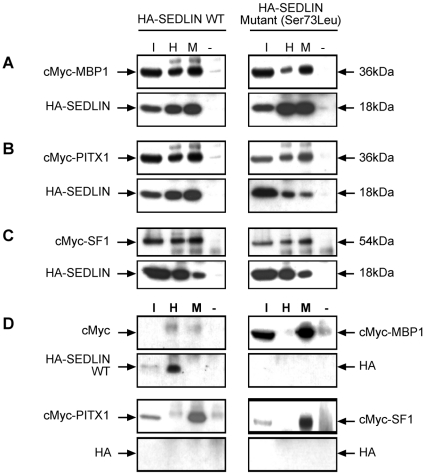
Interactions between SEDLIN, and MBP1, PITX1 and SF1.Co-immunoprecipitation studies using COS7 cells demonstrated interactions between wild-type SEDLIN, mutant SEDLINs (Asp47Tyr, Ser73Leu, Phe83Ser, Val130Asp and Gln131Stop, only data from Ser73Leu SEDLIN shown) and MBP1, PITX1 and SF1. (A) cMyc-MBP1 co-transfected with wild-type or mutant HA-SEDLIN; (B) cMyc-PITX1 co-transfected with wild-type or mutant HA-SEDLIN; (C) cMyc-SF1 co-transfected with wild-type or mutant HA-SEDLIN; and (D) empty cMyc vector co-transfected with HA-SEDLIN or empty HA vector co-transfected with cMyc-MBP1, cMyc-PITX1 or cMyc-SF1 constructs. Lysates were incubated with either anti-cMyc polyclonal antibody (M) or anti-HA polyclonal antibody (H), or without any antibody as a negative control (−) and immunoprecipitated with Protein G-Sepharose beads. Protein complexes were eluted and resolved on SDS-PAGE followed by Western blot analysis using an antibody to the cMyc epitope for MBP1, PITX1 and SF1, and to the HA epitope for SEDLIN. Five percent of the lysate (input (I)) that was used for the immunoprecipitation was electrophoresed in parallel with the immunoprecipitated lysates. Wild-type SEDLIN co-immunoprecipitated MBP1, PITX1 and SF1 and the SEDLIN mutations (Asp47Tyr, Ser73Leu, Phe83Ser, Val130Asp and Gln131Stop) did not disrupt these interactions (representative data for mutant Ser73Leu SEDLIN shown).